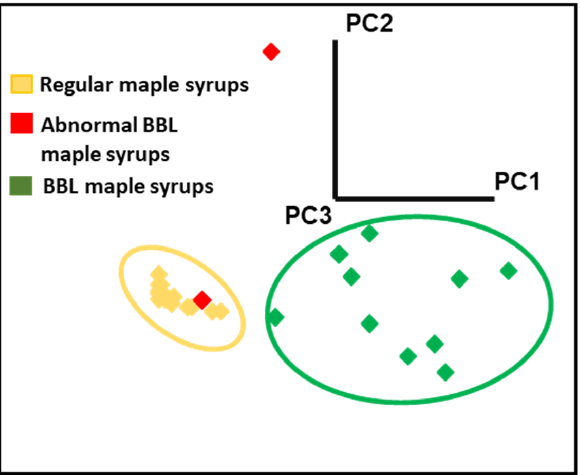
Figure A1. Soft independent modeling of class analogy (SIMCA) projection plots of classification of authentic BBL samples from suspicious BBL and traditional maple syrup samples by GC ‐ MS.